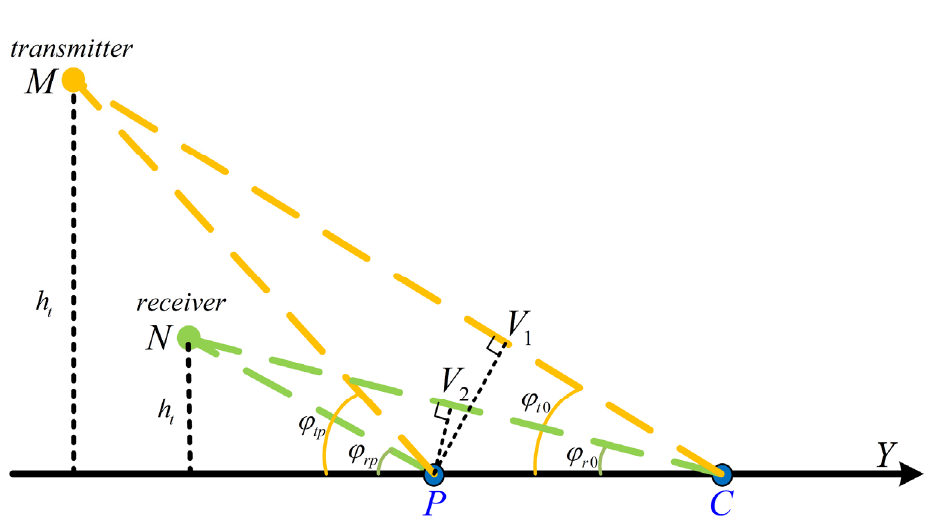
R and R , respectively. Then, the range of point P can be expressed as 0 t 0 r